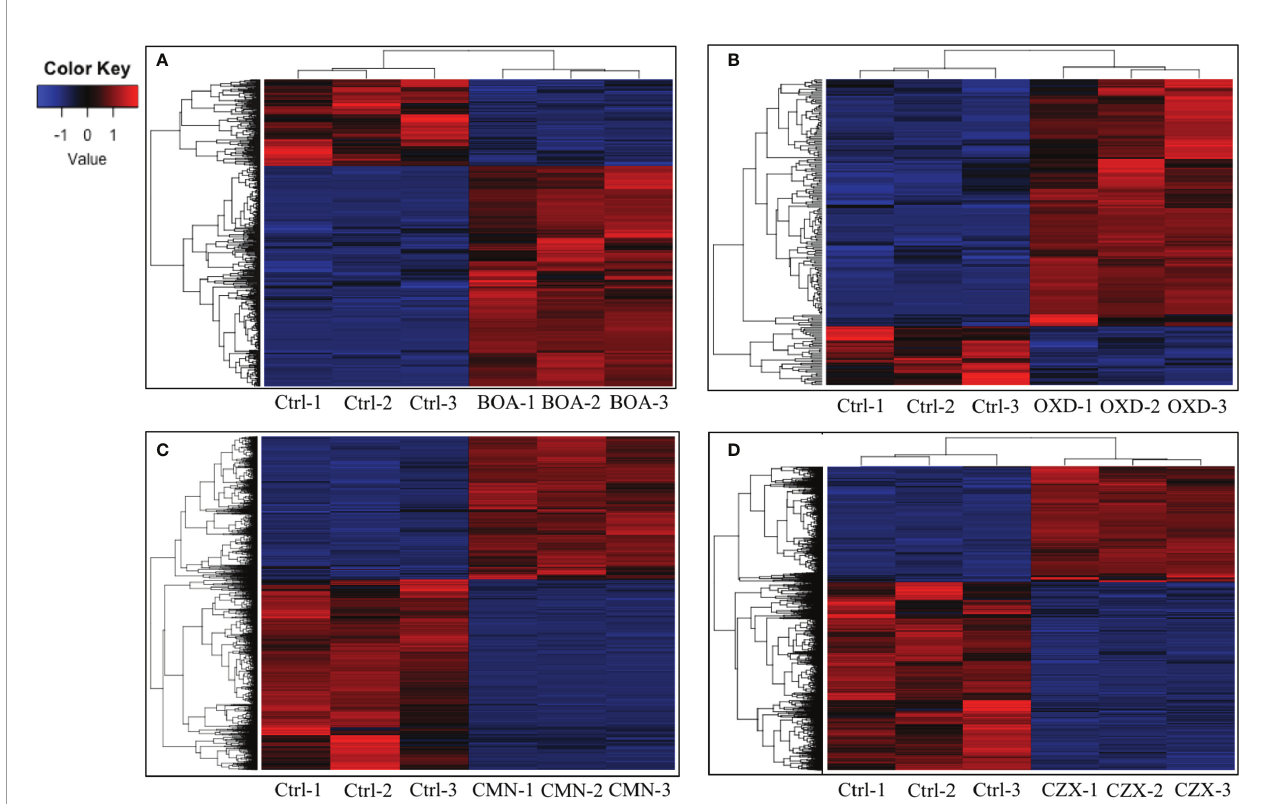
FIGURE 2 | BOA, OXD, CMN, and CZX elicit differential gene expression. Heatmaps showing transcription levels of differentially expressed genes upon exposure to BOA (A) , OXD (B) , CMN (C) , and CZX (D) . The Y-axis represents genes that are clustered and colored by z-score. See the colored key. The X-axis shows the three biological replicates of each